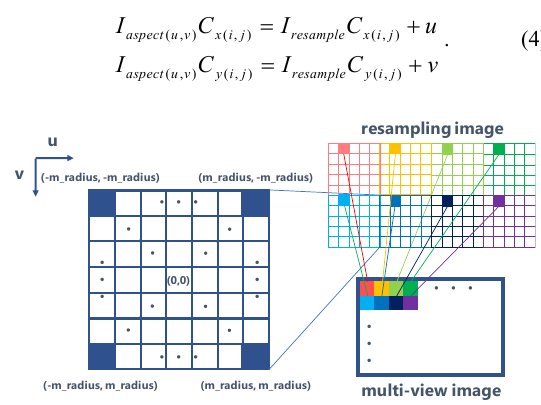
Figure 7. Multi-view image generation